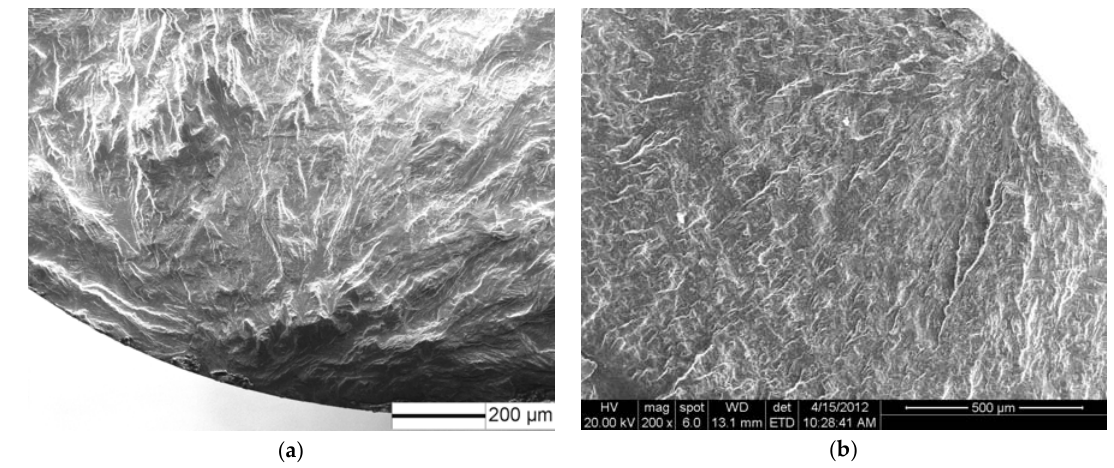
Figure 4. Fatigue fracture surface of TC21 titanium alloy: ( a ) basketweave of 60 μ m at σ = 550 MPa, N = 2.37 × 10 5 cycles; ( b ) basketweave of 40 μ m at σ = 610 MPa, N = 1.15 × 10 6 cycles.